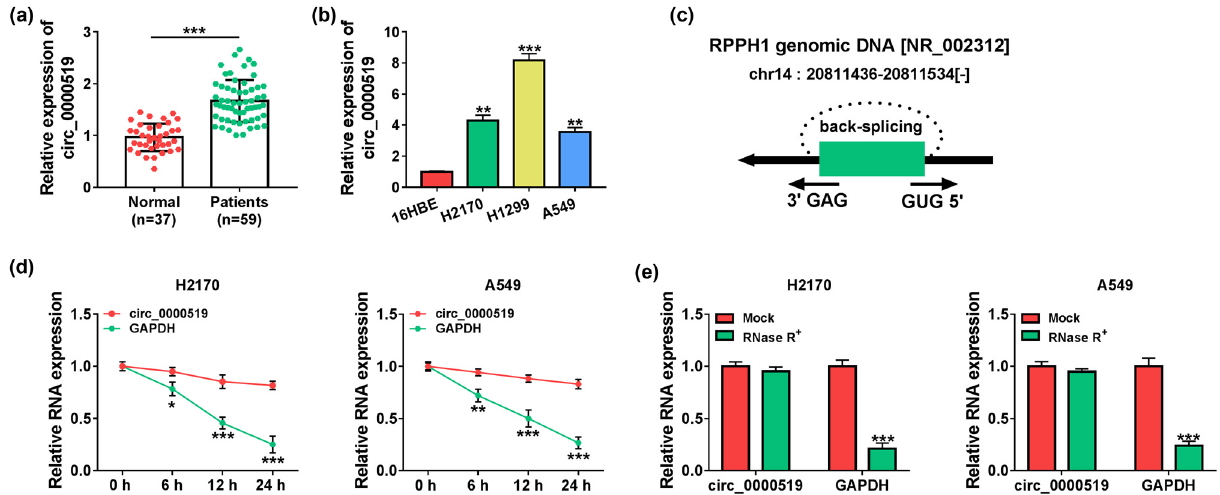
Figure 1: circ_0000519 level is increased in NSCLC. ( a ) circ_0000519 level was measured via qRT - PCR in the serum samples of NSCLC patients ( n = 59 ) or normal subjects ( n = 37 ) . ( b ) circ_0000519 abundance was detected via qRT - PCR in H2170, H1299, A549, and BEAS